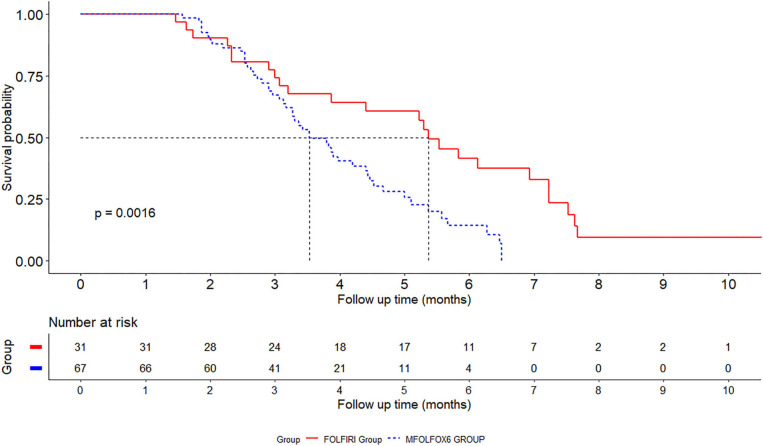
Kaplan–Meier survival curves for fluorouracil combined with oxaliplatin (FOLFOX) and fluorouracil combined with irinotecan (FOLFIRI) in gastrointestinal cancer patients.